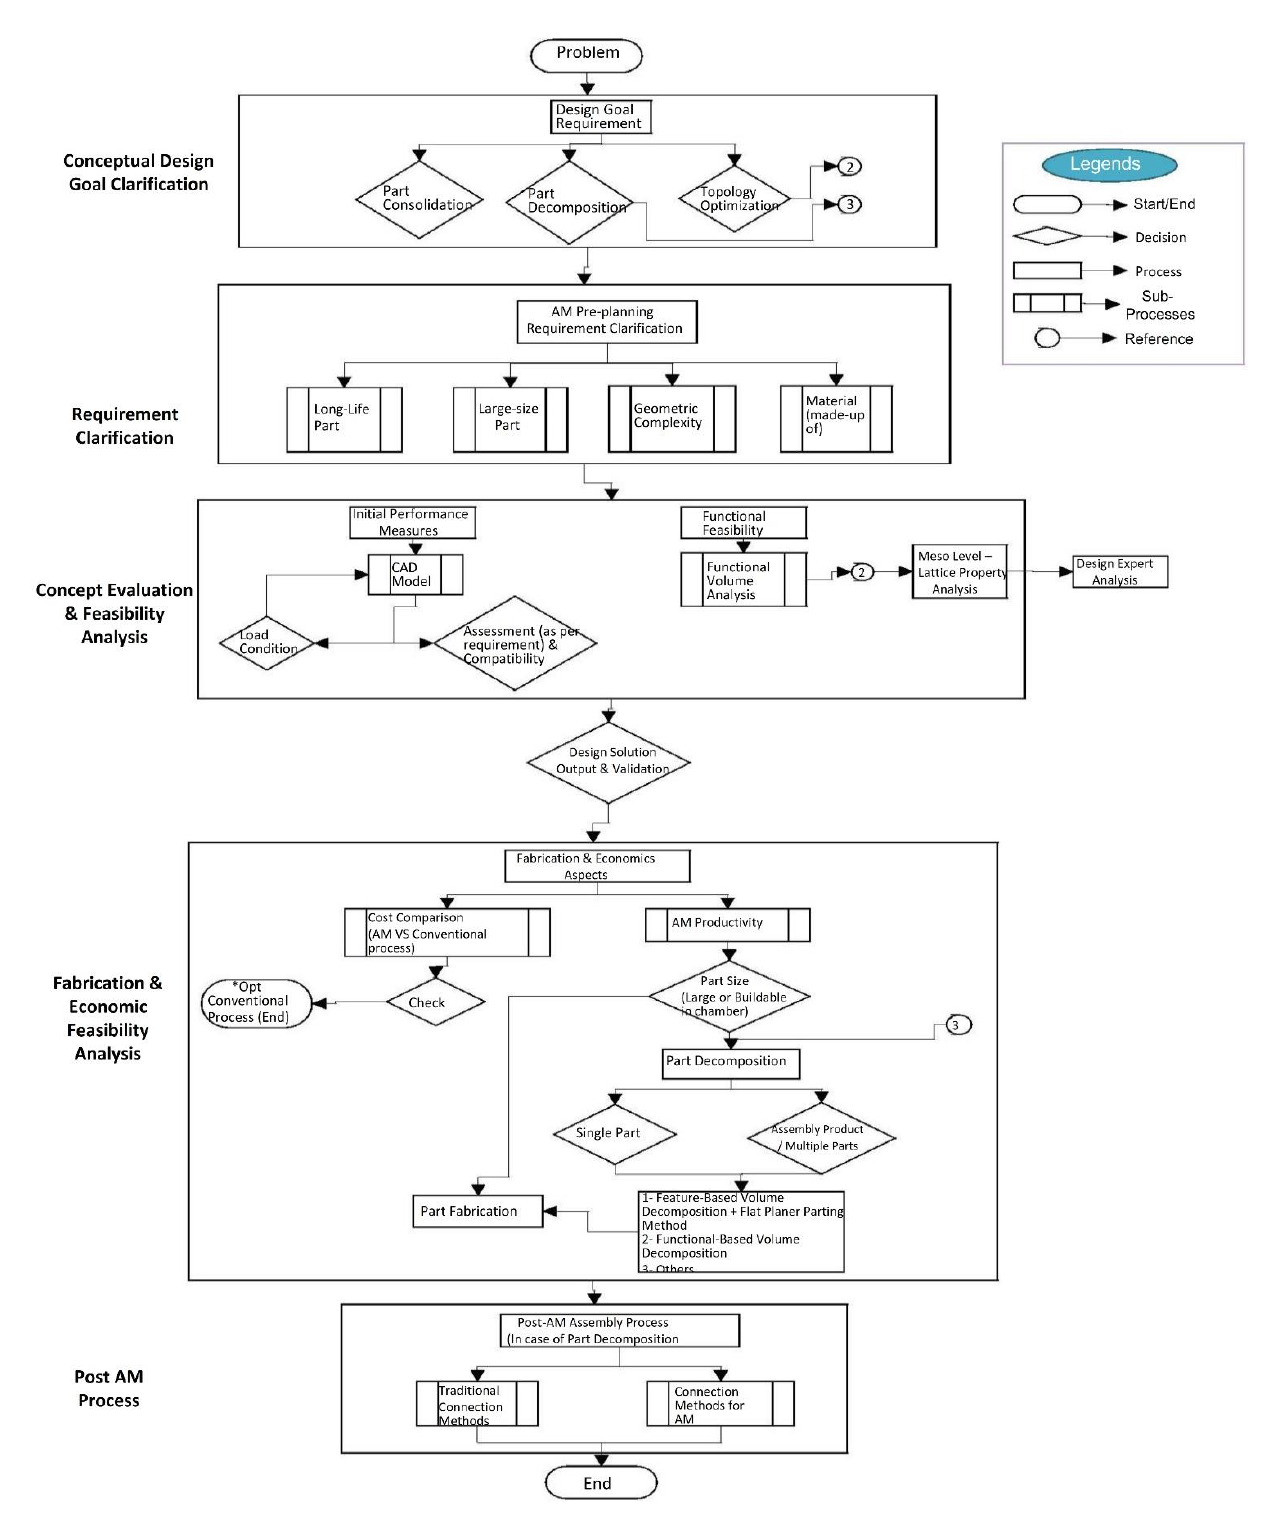
Fig. 7. Proposed Decision Support System for Large-Size AM